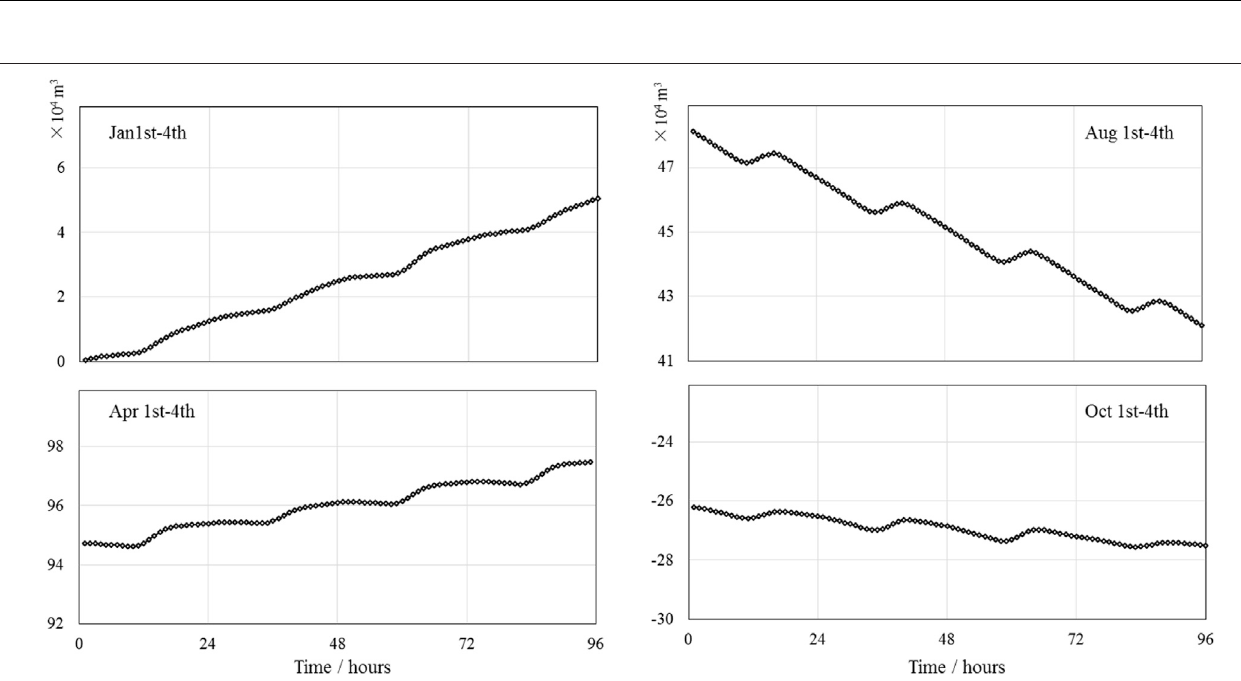
Frontiers in Earth Science |